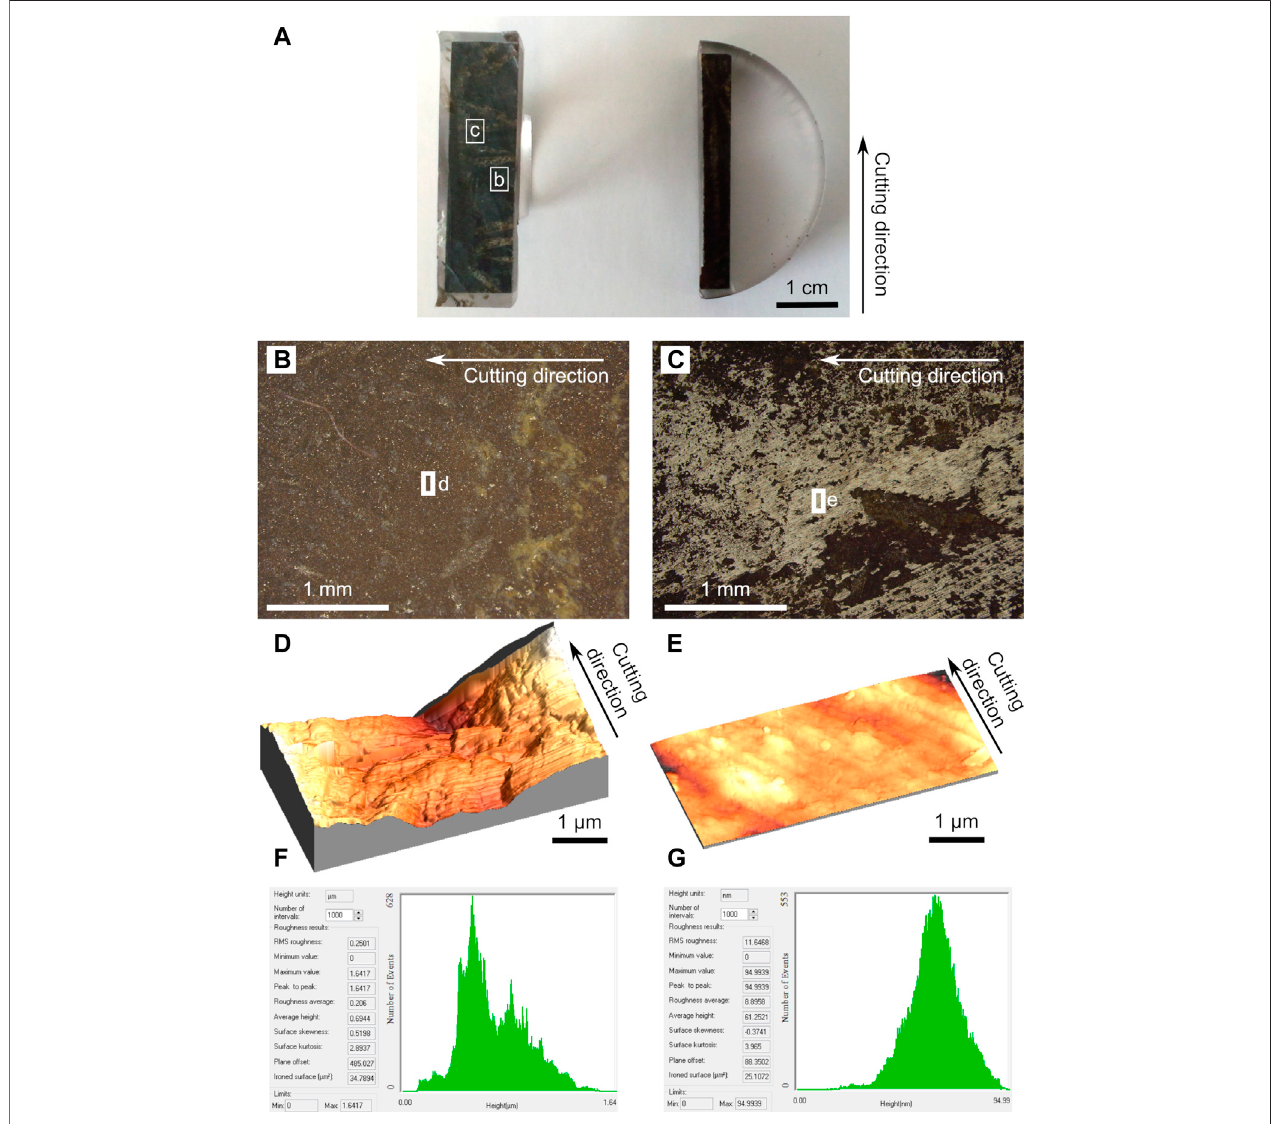
FIGURE9| KomatiitesampleaftercuttingwiththeStruersSecotom-10discsaw. (A) Photographofthetwopartsofthesample. (B,C) Opticalmicroscopyimages in re fl ected light of the areas indicated in (A) . (D,E) AFM images of the areas indicated in (B,C) respectively and (F,G) associated roughness measurement.